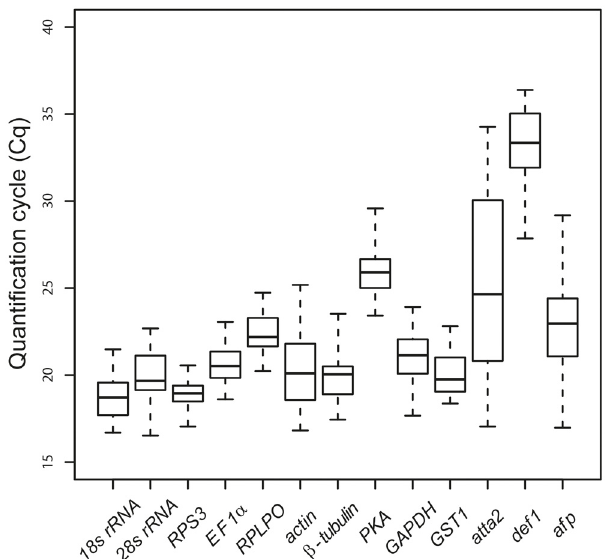
Fig 1. Distribution of quantification cycle (Cq) values for all L . sericata candidate genes obtained by qRT-PCR. Data for all na ï ve and immune-challenged samples were pooled (n = 42). Boxplots show first to third quartile of values in the box, the center line indicates the median, vertical dotted bars extend to the highest and lowest value.